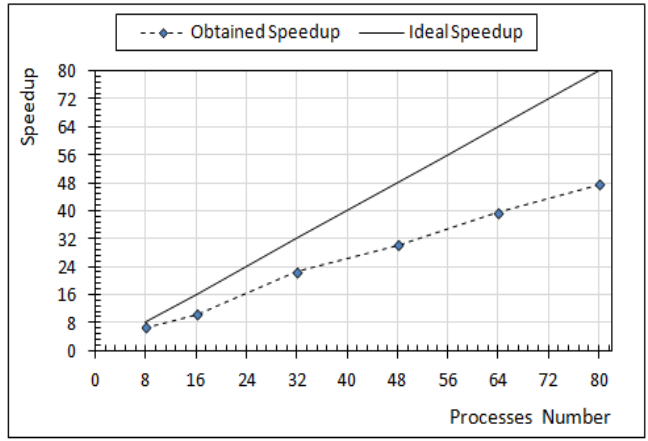
Figure 13. Speedup as a function of the number of